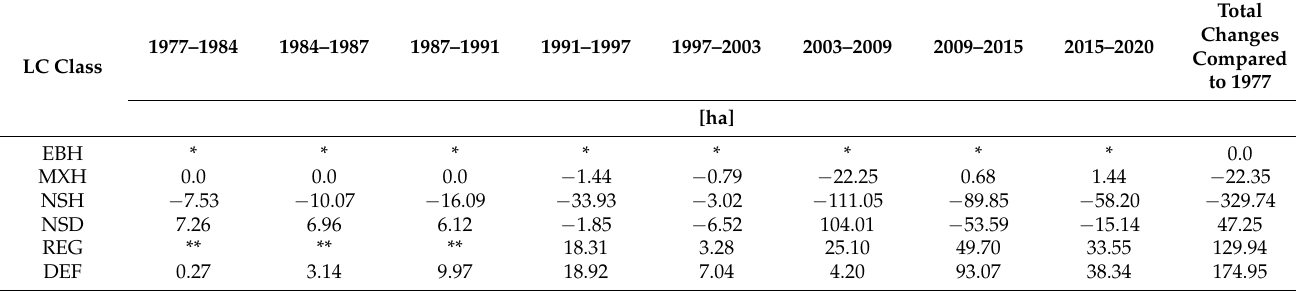
Table 4. Change in the area of LC classes relative to the previously analyzed date in subarea B. *—no change was observed, **—class not